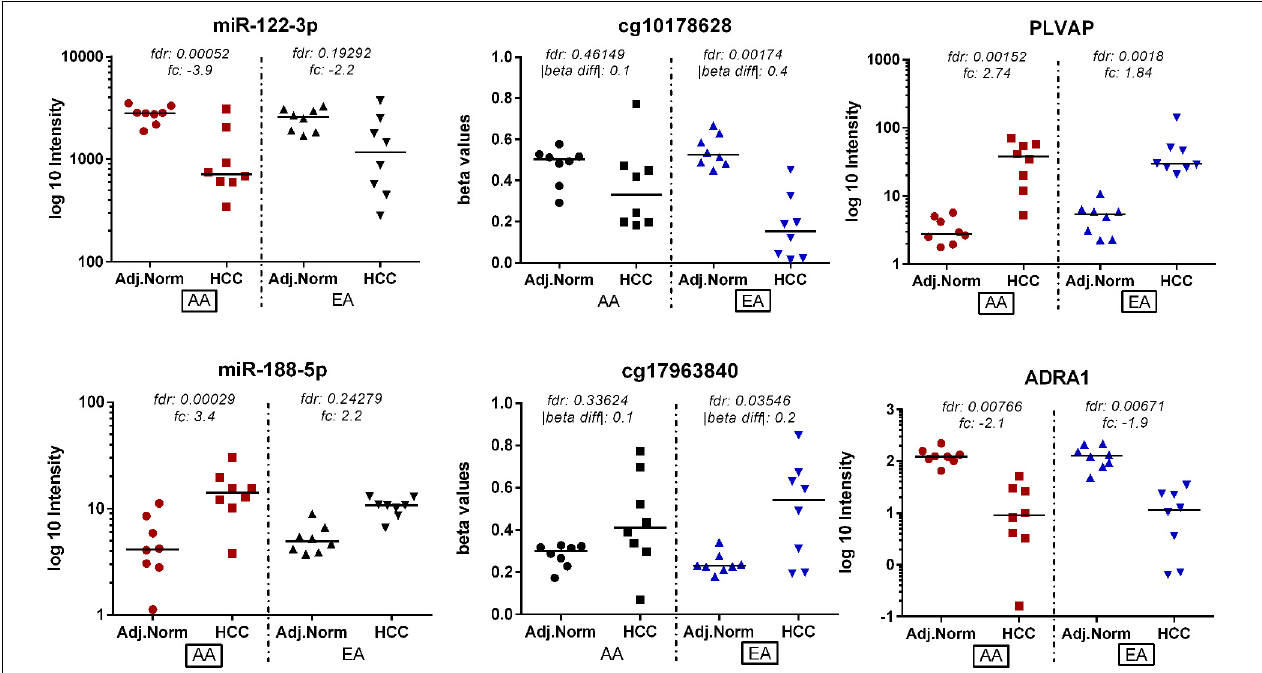
FIGURE 6 | Genes identified as being potentially regulated by different epi-mechanisms in AA vs. EA. These target mRNAs are significantly up- or down- regulated in tumor vs. non-tumor tissues in both AA and EA. However, miRNA targeting these genes are differentially expressed only in AA and CpG sites located in the promoters of these genes are differentially methylated only in